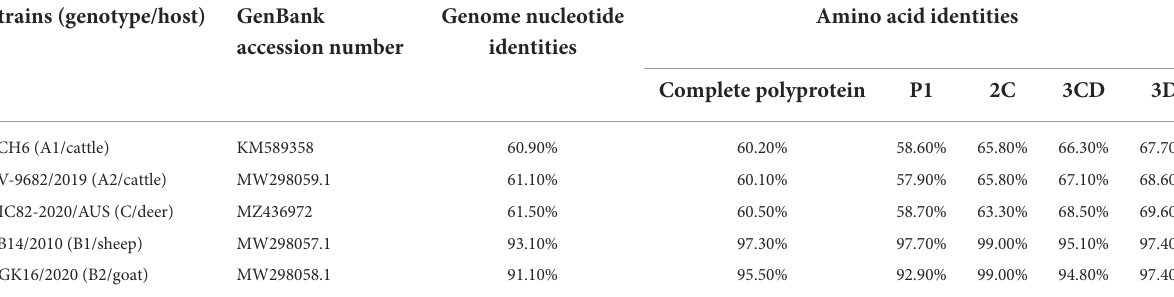
TABLE 4 Nucleotide and deduced amino acid similarity of the new “Bopivirus B” strain SWUN/B1/2022 and other five representative species of Bopivirus in the NCBI